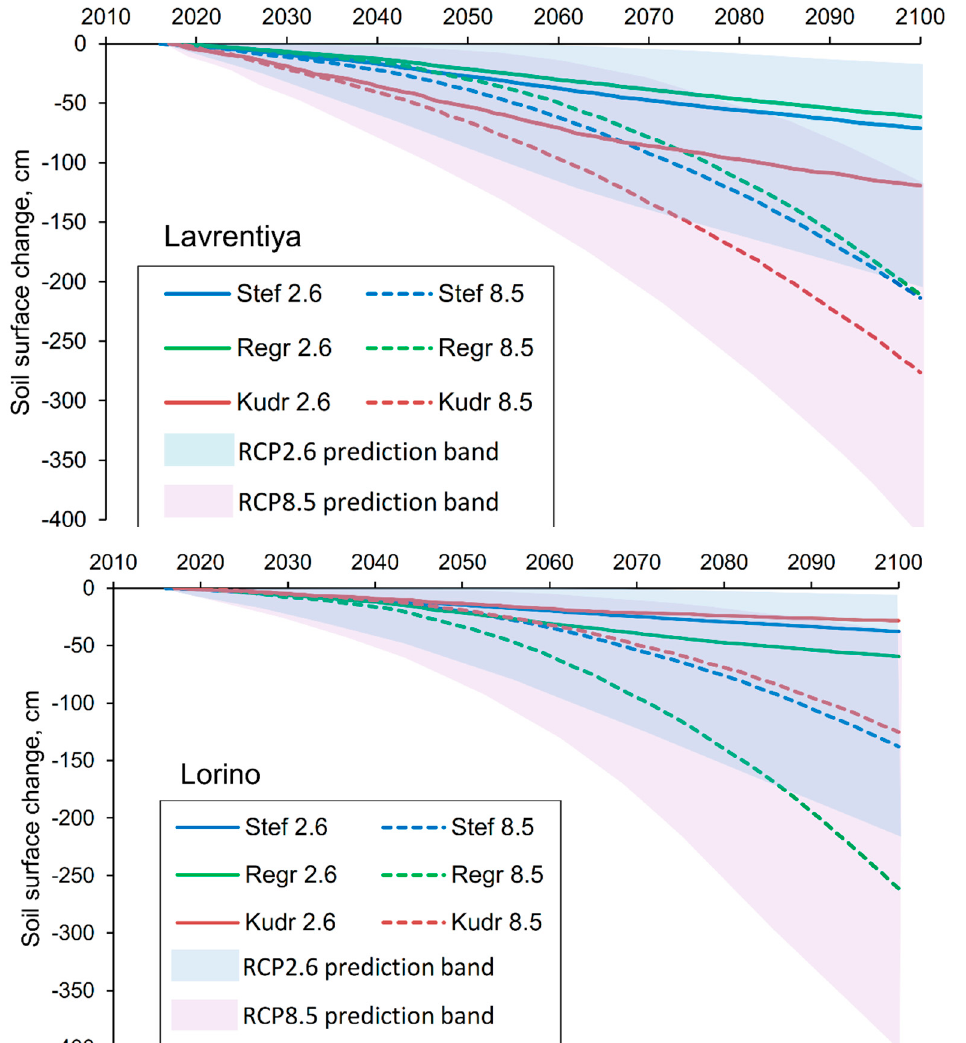
Figure 9. Thaw subsidence projections at Lavrentiya and Lorino CALM sites for 2017–2100 based on 3 active layer thickness models and RCP 2.6 and 8.5 climatic scenarios. The uncertainty bound is calculated as described in Section 3.4.